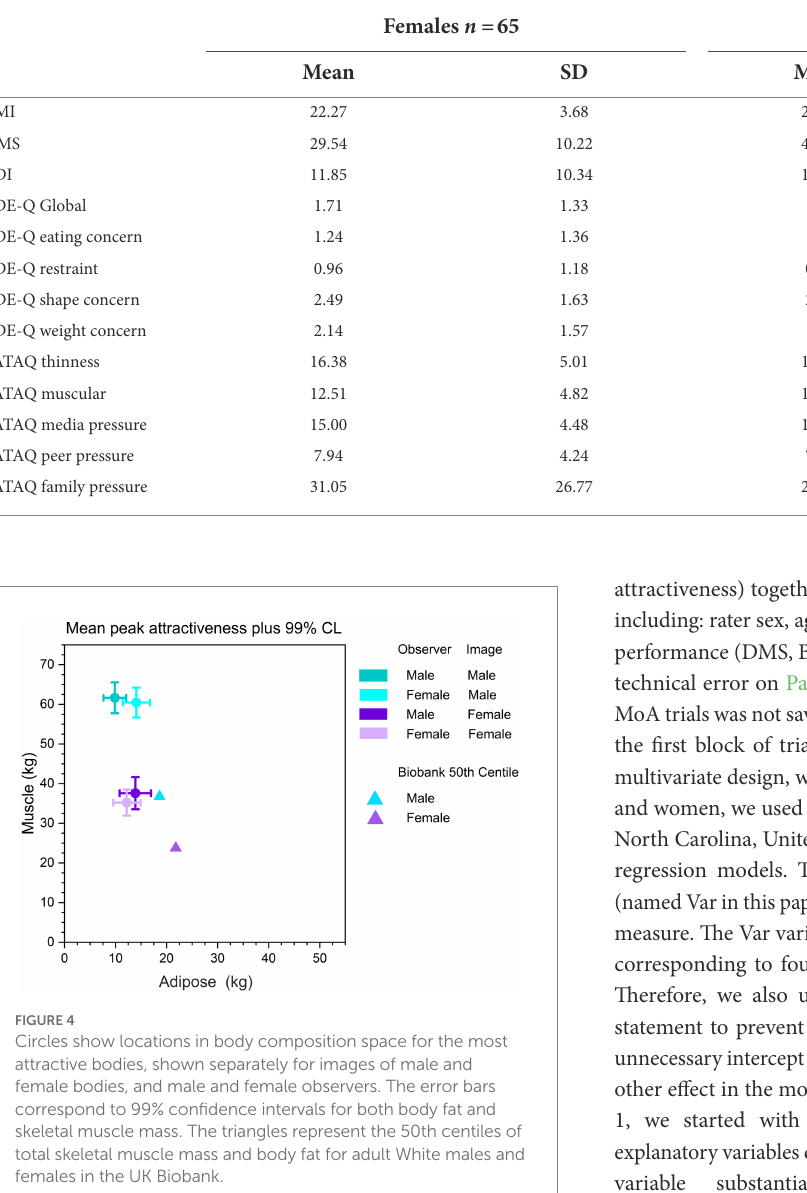
TABLE 4 Participant characteristics and psychometric scores for Study 2.